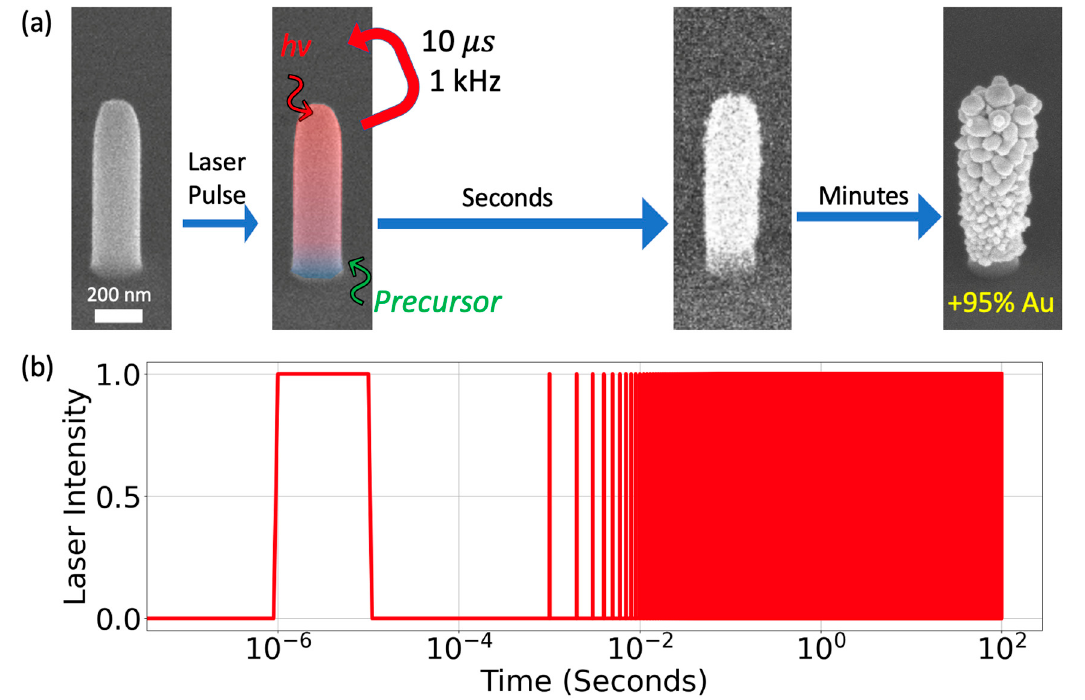
Figure 1. Schematic illustrating the temporal evolution during the selected area deposition process. ( a ) SEM images of an as-deposited FEBID nanopillar and subsequent images during the deposition process, where one is artificially colored to visualize the thermal effect of the laser. ( b ) A log time versus irradiance plot illustrating the various time scales that are operative where for instance the pulse width is 10 µs, the repetition rate is 1 kHz and the total processing time 200 s (with a 0.1% duty cycle and thus total laser on time of 0.2 s).